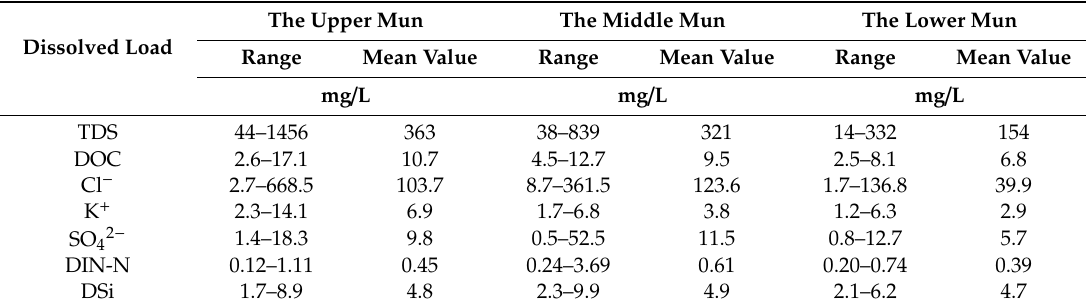
Figure 3. Evolution of contents of TDS, Cl − , and SO 42 − from the upper to the lower reaches. Table 1. Distributions of DOC and major ions in the Mun